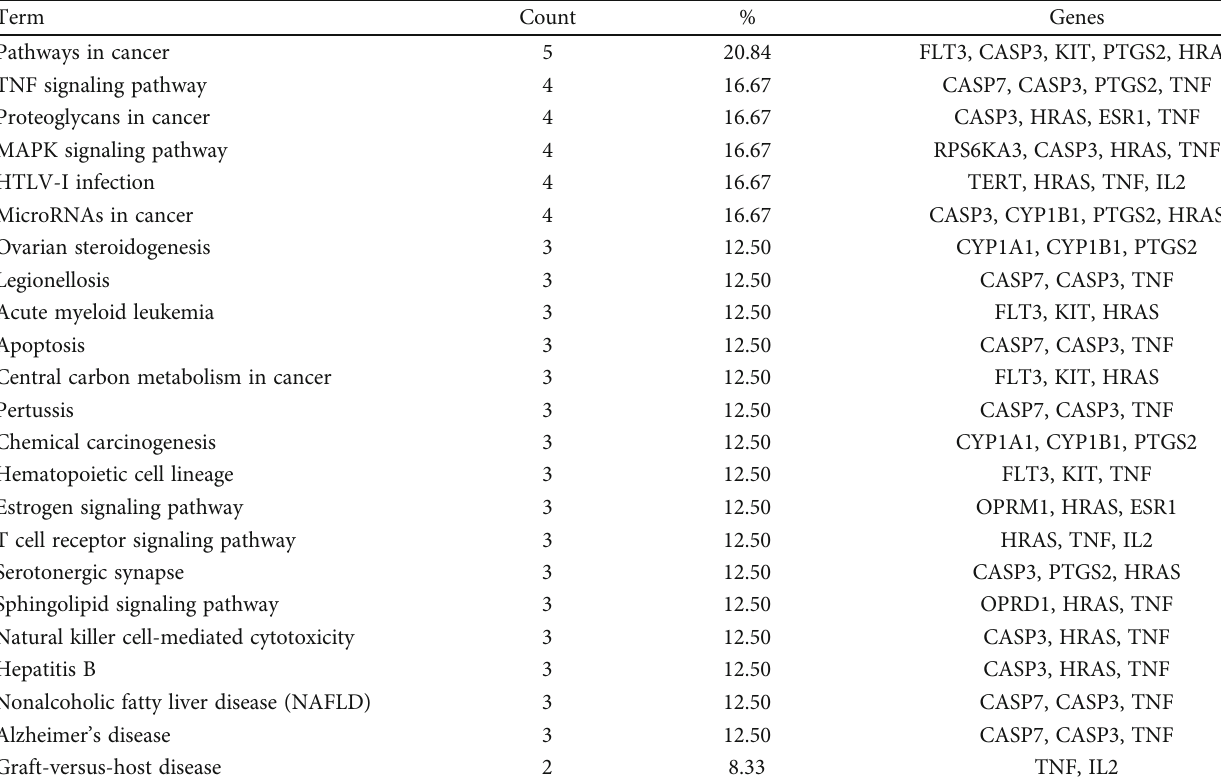
Table 1: DAVID analysis of overlapped